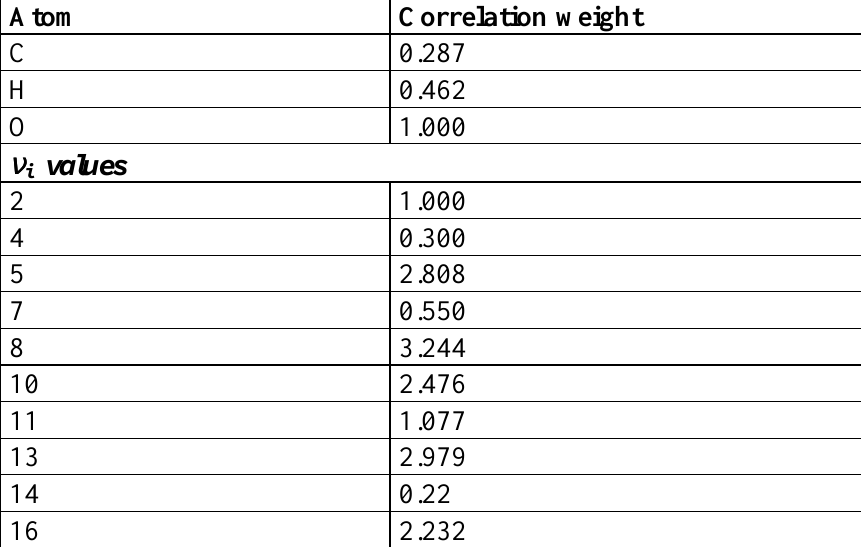
Table 1. Correlation weights (CW) for atoms and extended connectivity